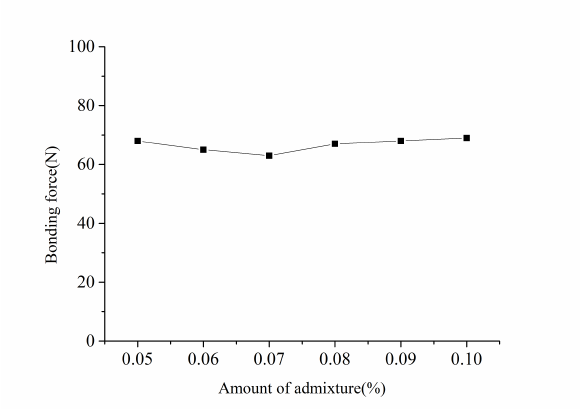
3.1.2 Ferrosilicon alloy powder on cubic compressive